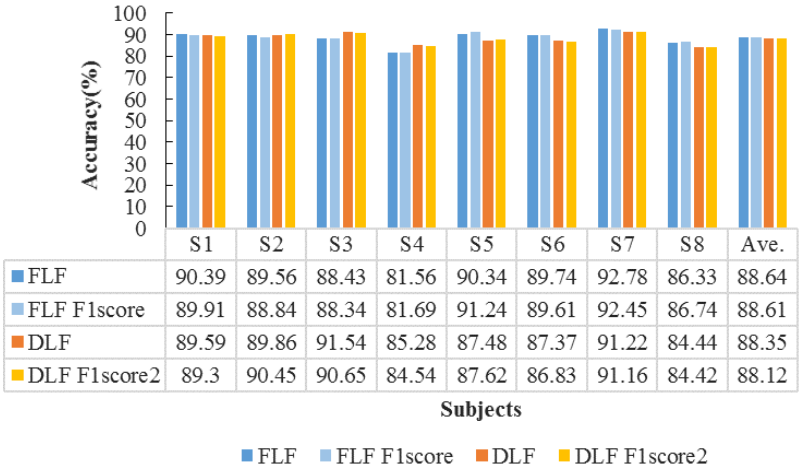
Figure 11. Features fusion-based on classification accuracies (%) for all subjects. Sensors 2018 , 18 , x FOR PEER REVIEW